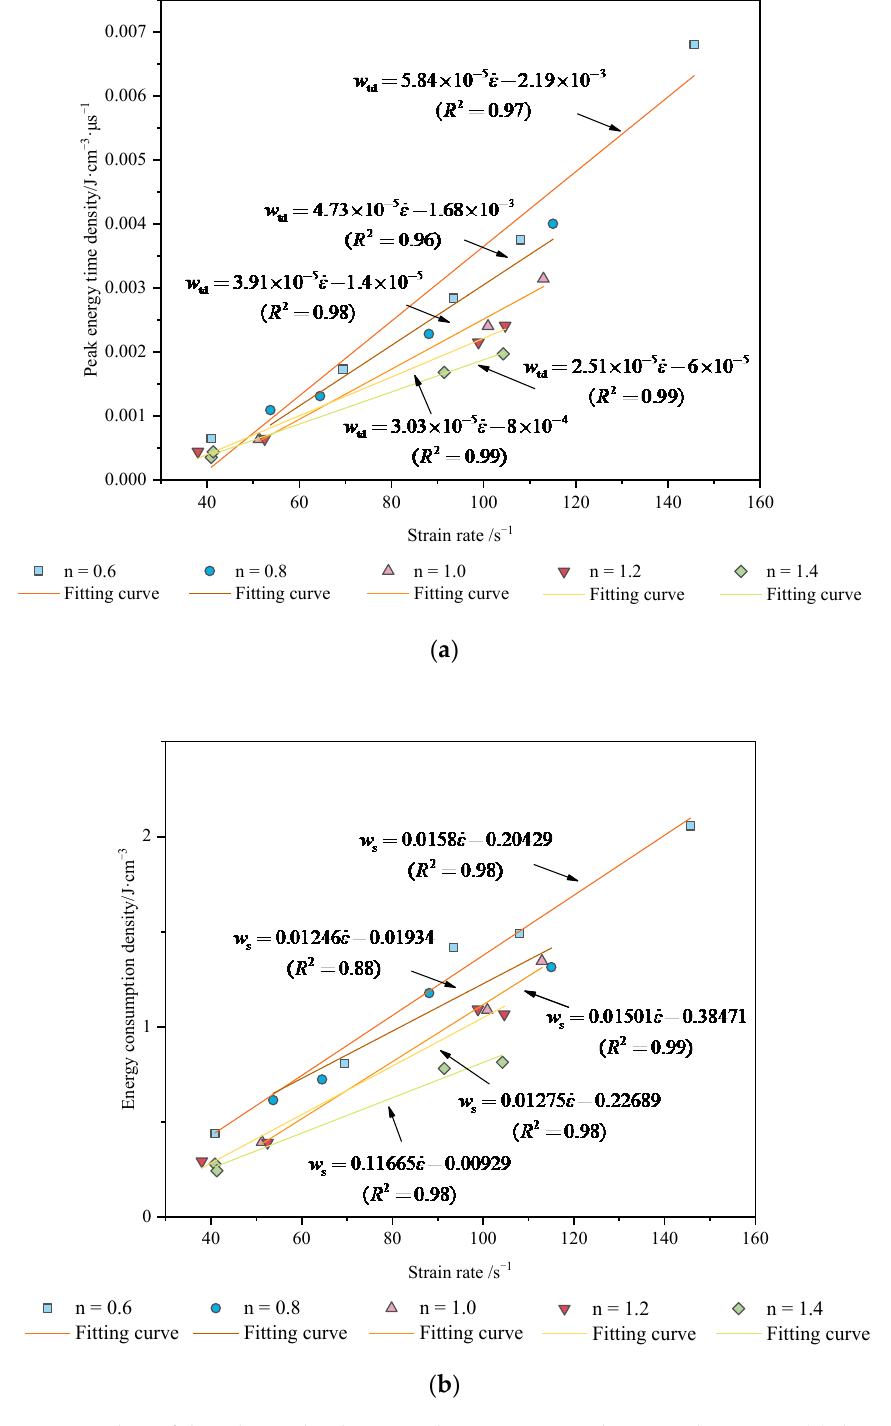
Figure 7. Plots of the relationship between the strain rate and energy absorption: ( a ) the peak energy time density curve; ( b ) the energy consumption density. time density curve; ( b ) the energy consumption